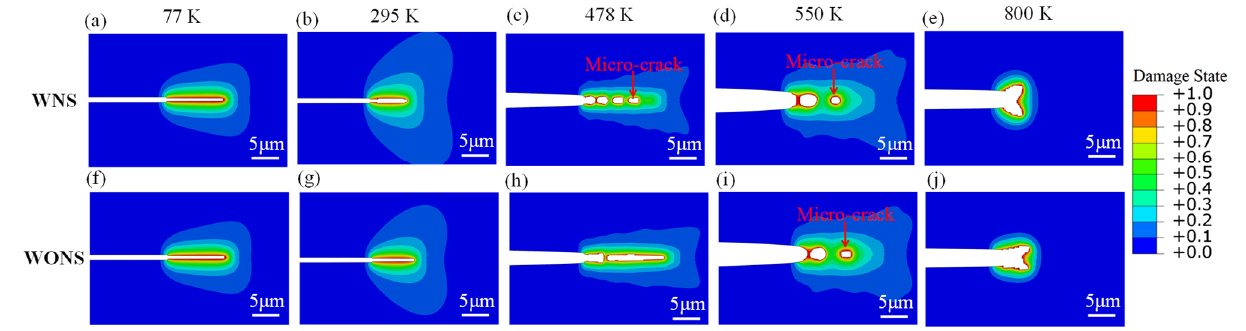
Figure 6. Crack propagation at different temperatures. ( a – e ) are the fracture processes with the NS effect, while ( f – j ) are the ones without the NS effect. Among them, ( a , f ) for 77 K and ( g ) for 295 K are the crack propagation of brittle fracture; ( b ) for 295 K and ( h ) for 478 K are the crack propagation of semi-brittle fracture; ( c ) for 478 K, ( d , i ) for 550 K are the crack propagation of micro-ductile fracture; ( e , j ) for 800 K are the crack propagation of ductile fracture, and a scale factor of 0.25 is applied to better present the deformation. “WNS” and “WONS” mean with and without the NS effect, respectively.